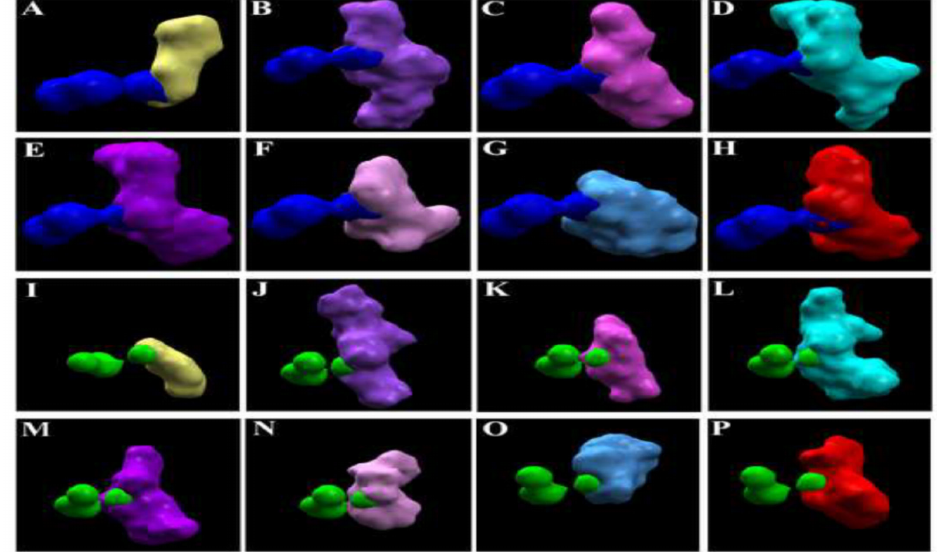
Figure 4. Electrostatic surfaces of the ligands at the active site of Os MDHAR. Overlapping electrostatic surfaces of docked ligands and metal ions. ( A ) MDHA; ( B ) GSH; ( C ) AsA; ( D ) JA; ( E ) 5-HT; ( F ) SA; ( G ) GA3 and ( H ) IAA with Al 3+ ; and ( I ) MDHA; ( J ) GSH; ( K ) AsA; ( L ) JA; ( M ) 5-HT; ( N ) SA; ( O ) GA3 and ( P ) IAA with Mn 2+ . The dark blue spheres represent the surfaces of Al 3+ and the green spheres represent Mn 2+